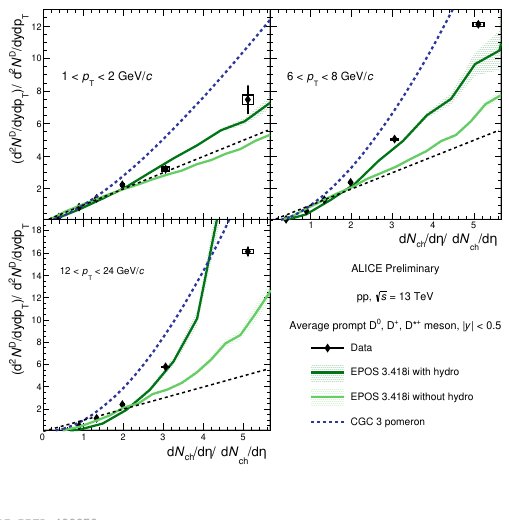
Figure 1: Average D 0 , D + , D ∗ + meson self-normalized yields in various p a function of charged-particle multiplicity in pp collisions at to different model predictions [ 2,3 ] . The systematic uncertainties on D-meson yield / d η / 〈 d N / d η 〉 is depicted as boxes. as well as on d N ch ch